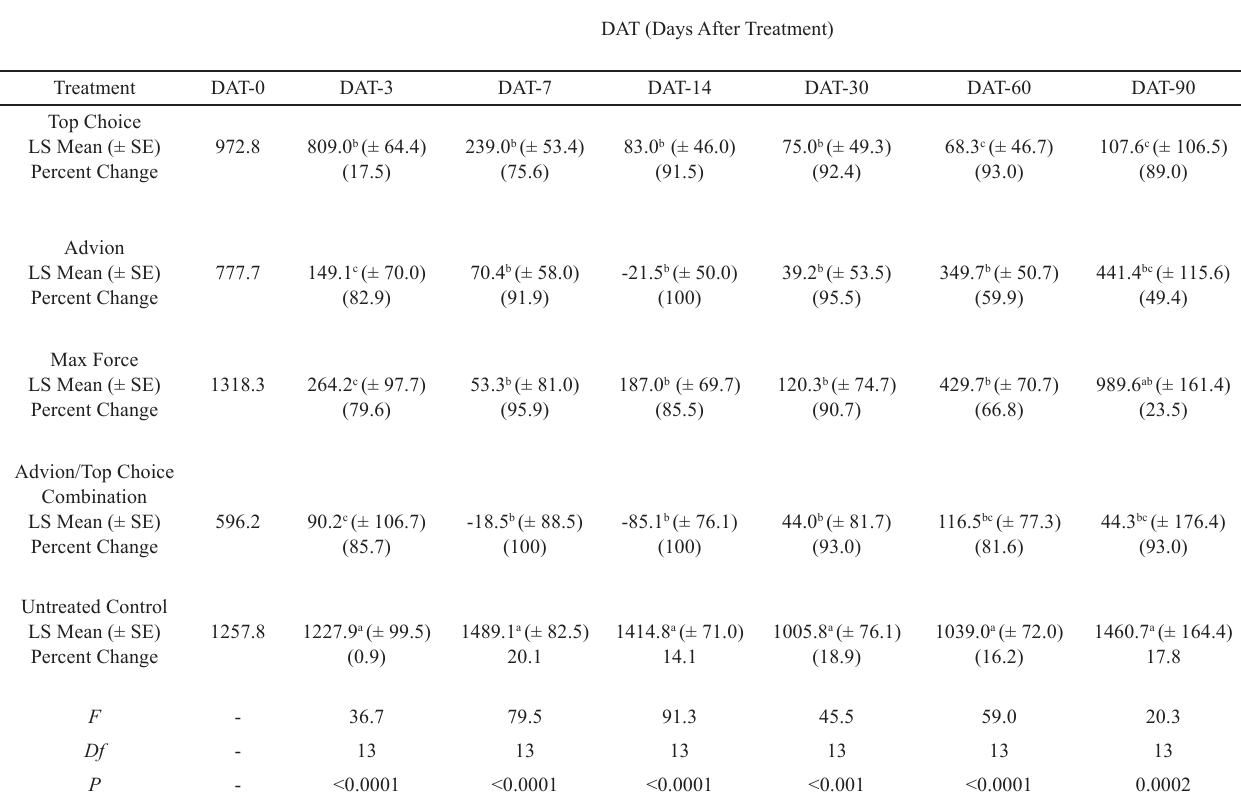
Means within a column followed by the same letter are not significantly different (Tukeys HSD mean separation test, α =